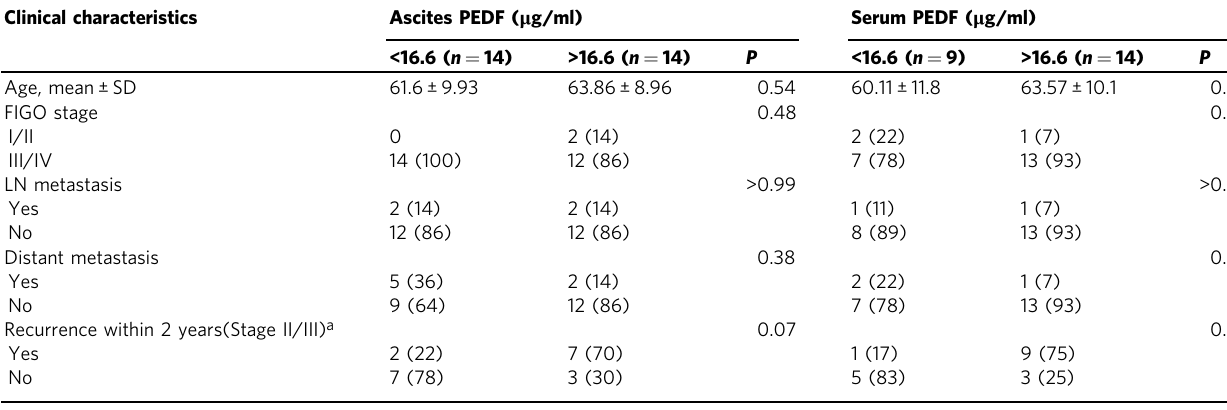
Values in the table are expressed as n (%). FIGO International Federation of Gynecology and Obstetrics. a Patients who achieved complete response after initial treatment were